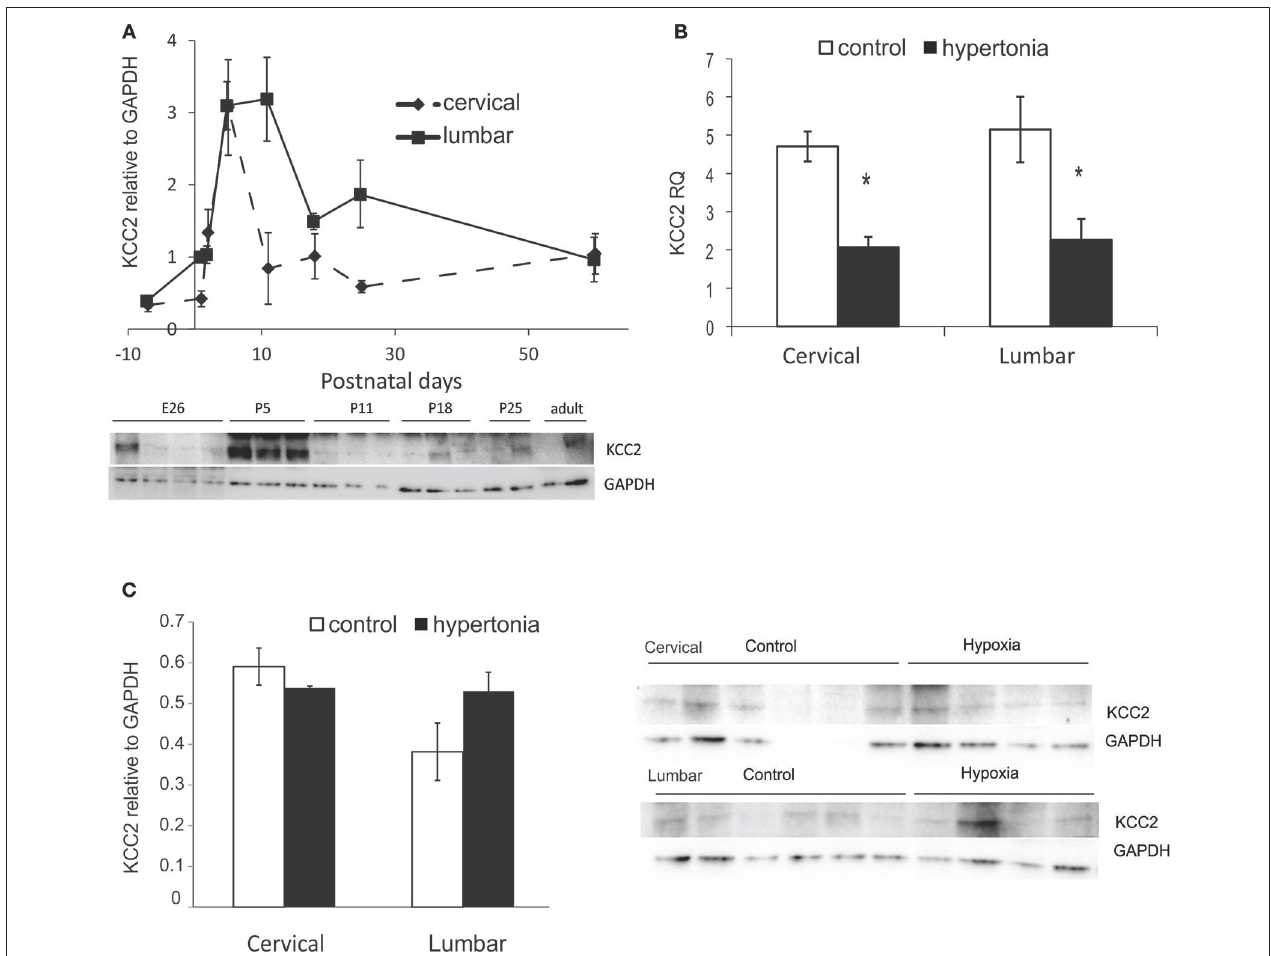
FIGURE 7 | Expression of potassium chloride transporter KCC2 in normal development and after antenatal H-I injury. (A) KCC2 protein expression during development from fetal to adult ages in cervical and lumbar cords, quantified by optical density of KCC2 band relative to housekeeping protein GAPDH on Western blot. (B) Relative gene expression of KCC2 in control and hypertonic P1 rabbits on RT-PCR. (C) Western blot of KCC2 in control and hypertonic P1 rabbits. * p <